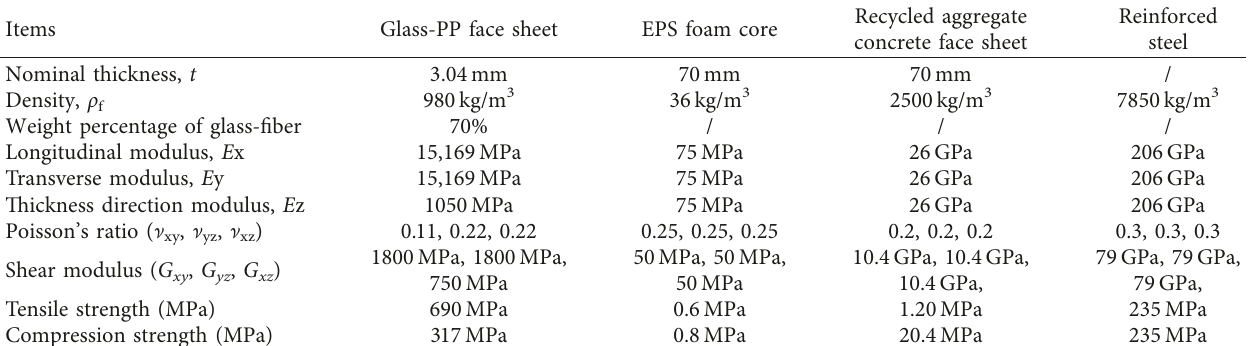
Figure 2: Manufacturing of ICSIPs: (a) the EPS core was bonded on GFRP; (b) steel mesh was setup; (c) the recycled aggregate concrete was cast; (d) a piece of ICSIP was made. Table 1: Mechanical properties of